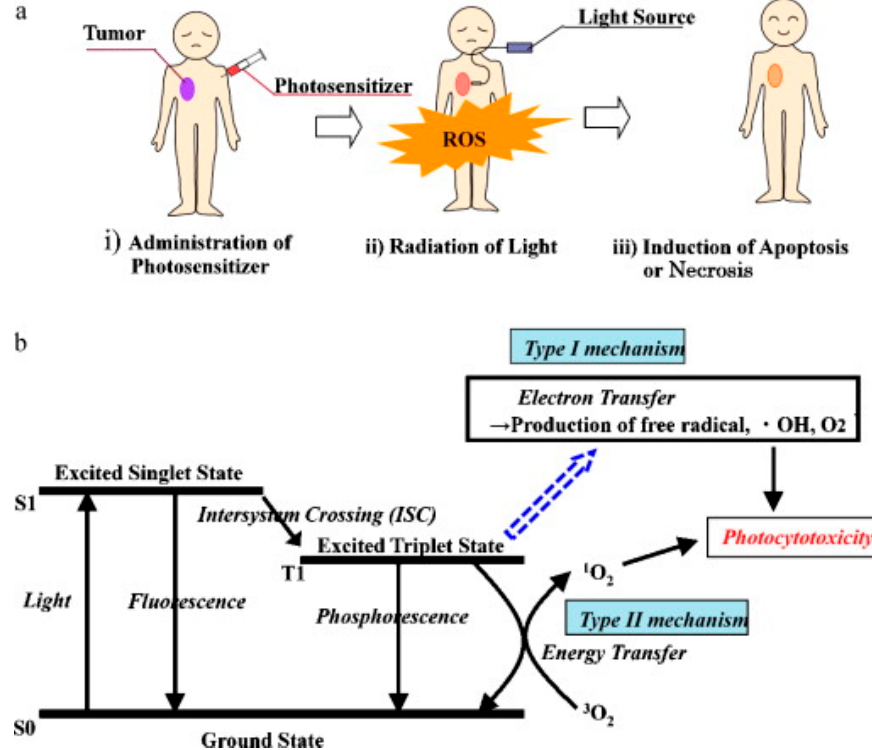
Figure 6. PDT mechanism: ( a ) profile of PDT treatment; ( b ) generation of excited states and reactive oxygen species (ROS). Reproduced from Yano et al. [62], with permission from Elsevier.